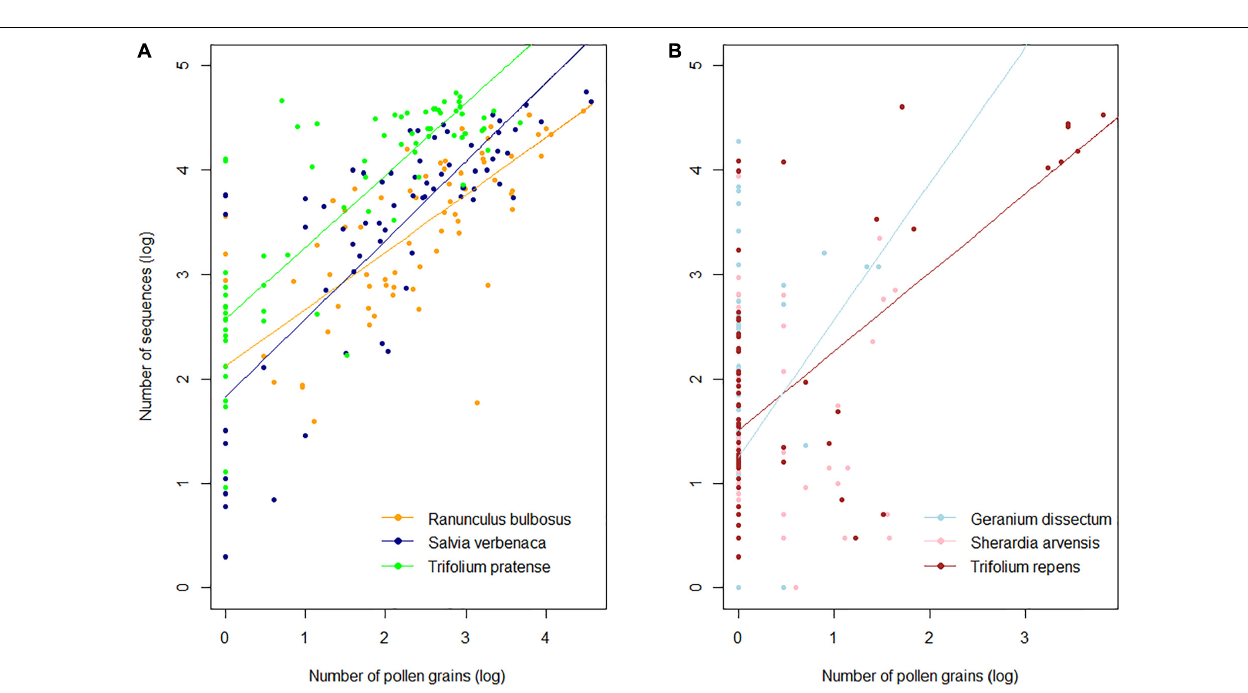
FIGURE 2 | Relationship between visitation frequency and sequence count in (A) frequently visited (linear mixed model; see Supplementary Table 6 for model parameters) and (B) rarely visited plant species (non-parametric Kendall’s correlation). All values were log 10 transformed.